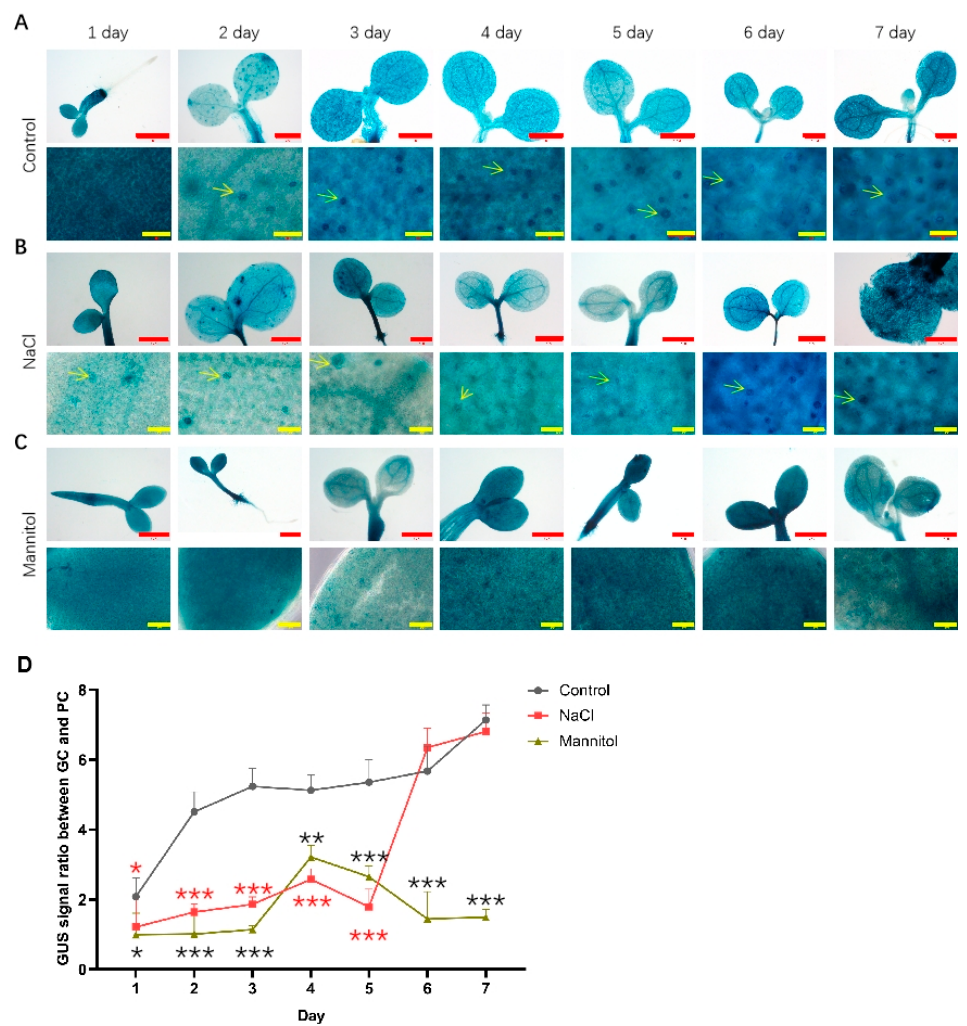
Figure 3. Analysis of the expression of PIF5pro:GUS after being treated with NaCl and mannitol. Analysis of the expression of PIF5pro:GUS in whole cotyledons (up panel) and lower epidermis during development of seedlings grown under control ( A ), NaCl ( B ), and mannitol ( C ) conditions, respectively. The seedlings of PIF5pro:GUS were grown in 1/2 MS plates plus 100 mM NaCl or 150 mM mannitol for 1–7 days, respectively; the seedlings of PIF5pro:GUS grown in normal 1/2 MS plates were used as controls. Then the seedlings were harvested and used for detecting the GUS activities by GUS staining as described in methods. Scale bar: red bar 1 mm, yellow bar 50 μ m. ( D ) Statistical analysis of the ratio of GUS signal in GC vs. PC. The data were analyzed by one-way ANOVA following Brown–Forsythe test.*: p < 0.05; **: p < 0.01; ***: p < 0.001. Red star: NaCl vs. control; black star: mannitol vs. control.